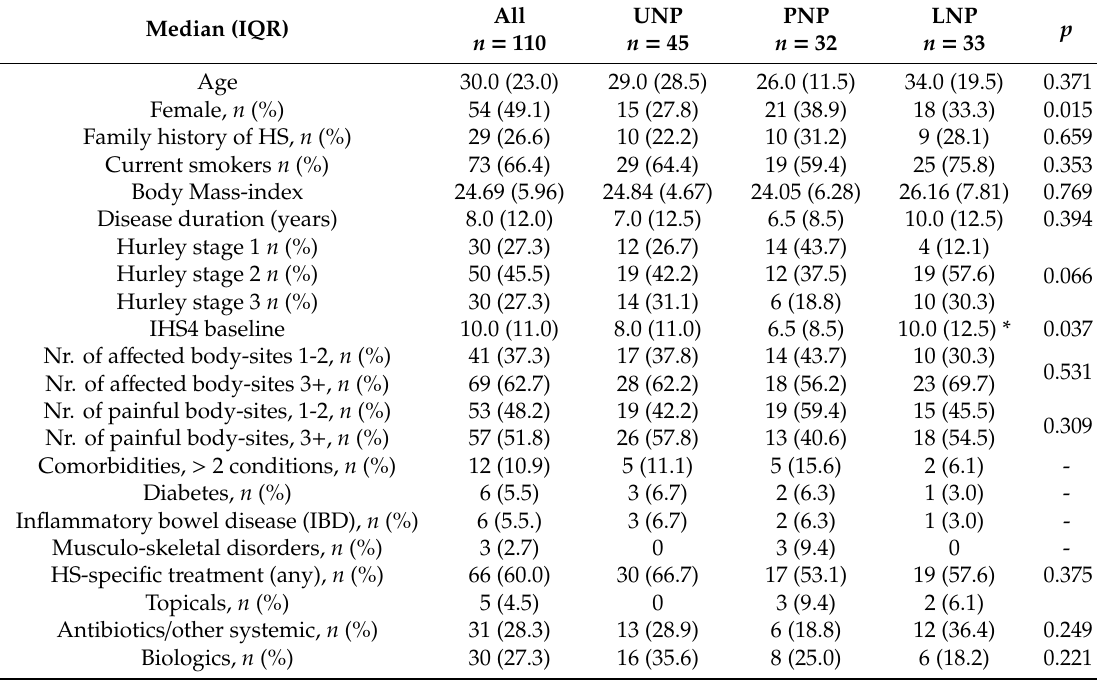
Table 1. Demographics and clinical characteristics of the hidradenitis suppurativa (HS) patient cohort according to PainDetect status: Unlikely Neuropathic Pain (UNP); Possible Neuropathic pain (PNP); Likely Neuropathic Pain (LNP). All n =